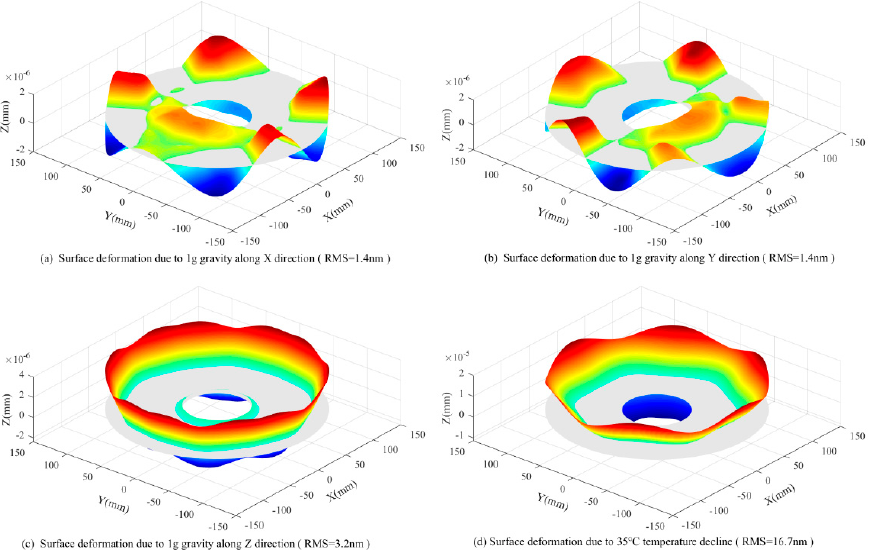
Figure 15. Surface deformation map.